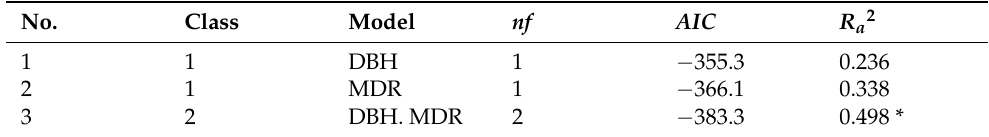
Table 7. Performances of candidate models for predicting wood density based on different models (control variant).